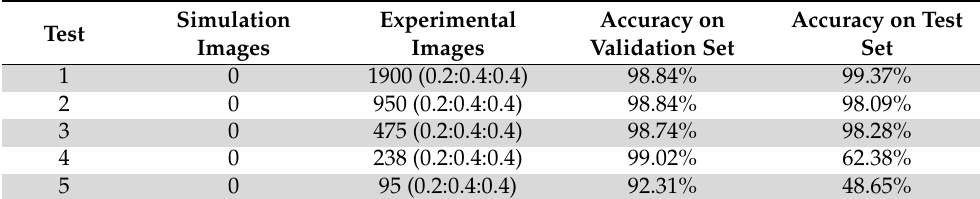
Table 1. Training results with only experimental dataset.